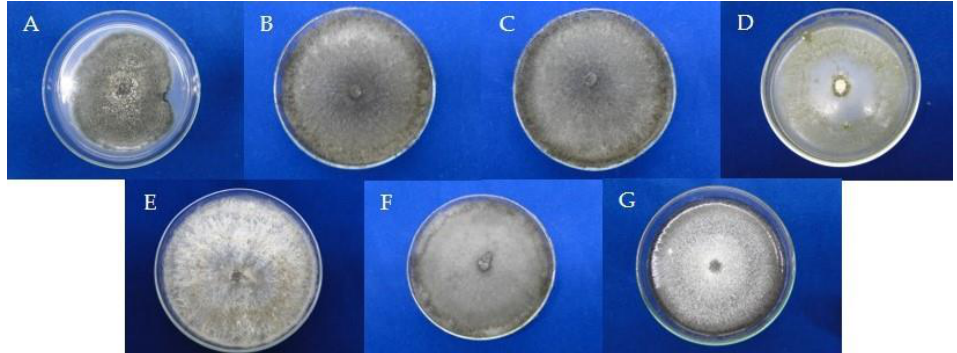
Figure 1. Endophytic fungi from Morinda citrifolia . Colonies of the fungi studied with seven days of growth in PDA medium. ( A ): NF17; ( B ): NC4; ( C ): NC5; ( D ): NC10; ( E ): NFrCs4; ( F ): NFrCs8; ( G ): NFrCs16. Table 2. Identification of the endophytic fungi of Morinda citrifolia . Isolate